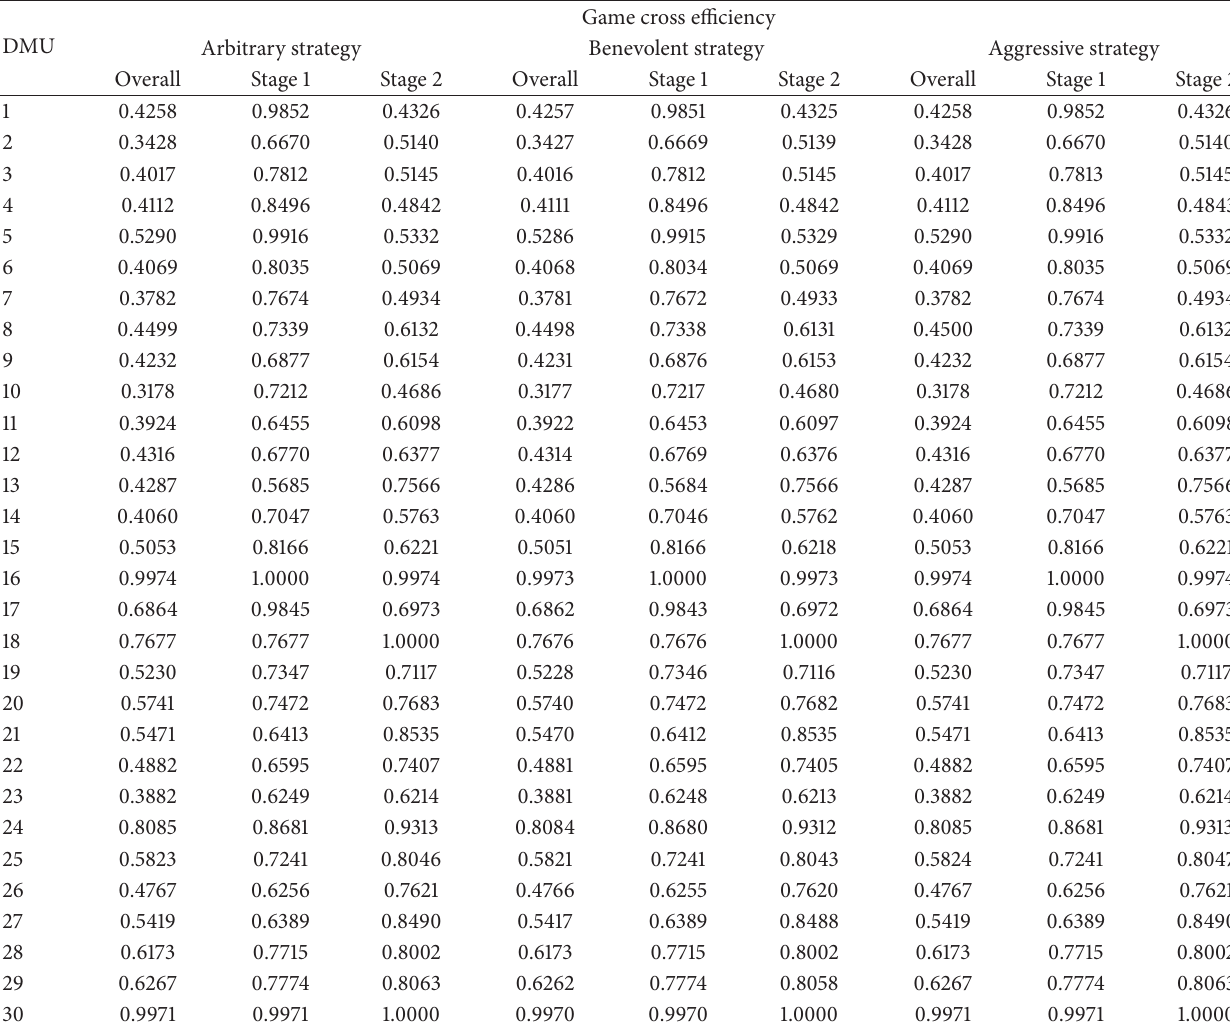
Table 2: Game cross efficiencies begin with different initial 𝛼 𝑜 .